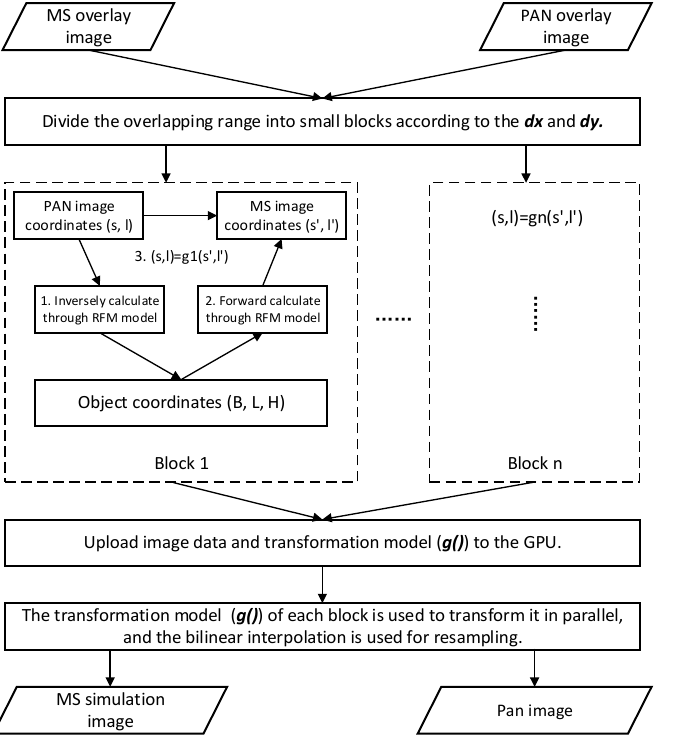
Figure 2. Differential